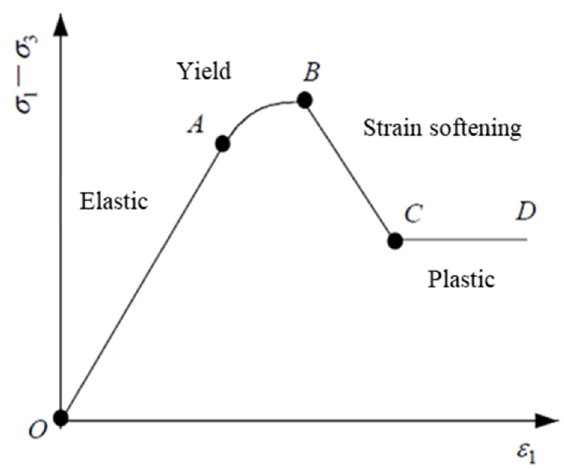
Figure 2. Stress-strain curve for typical rock unloading.